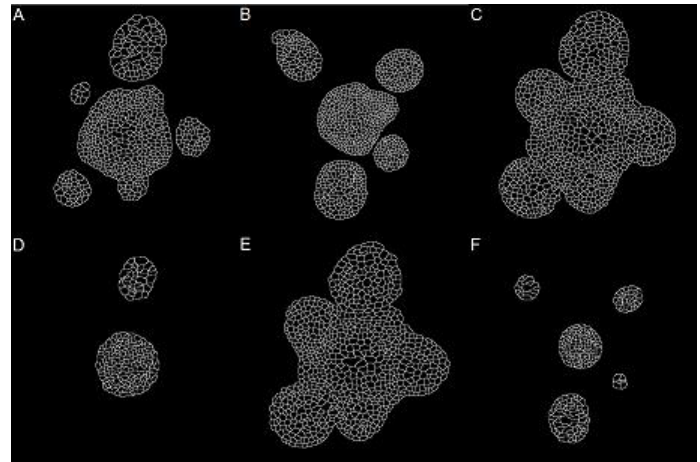
(0.1) and Figure 8C the coverage and sensitivity indices, where the maximum values of each iteration